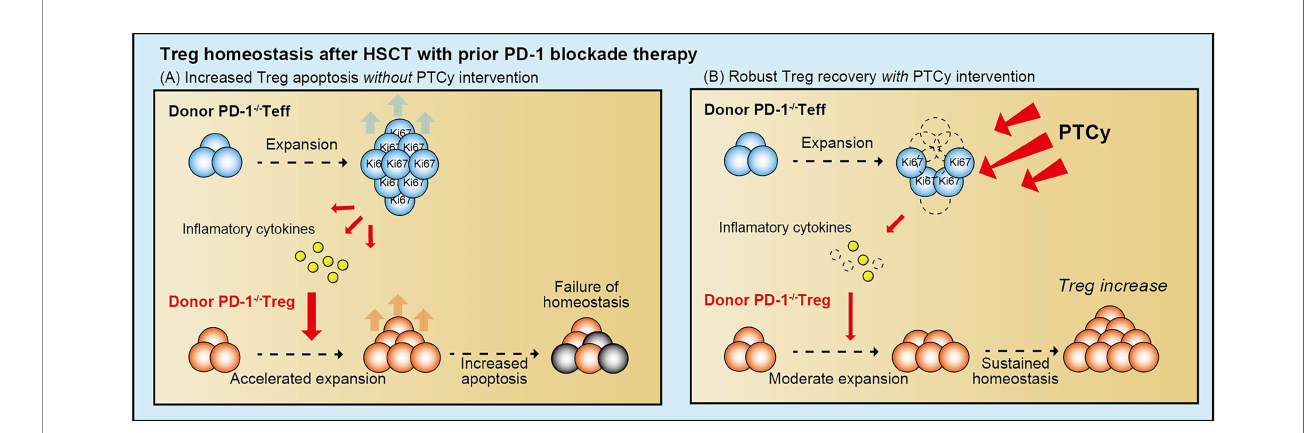
FIGURE 5 | The role of PD-1 in Treg homeostasis after allogeneic HSCT. PD-1 de fi cient effector T cells aggressively proliferate after HSCT and produce large amounts of in fl ammatory cytokines. The highly in fl ammatory cytokine milieu accelerates the proliferation of PD-1 de fi cient Tregs, but they cannot maintain proliferation due to their high susceptibility to apoptosis. Unbalanced reconstitution of T-cell subsets results in severe GVHD (A) . In contrast, with PTCy intervention, alloreactive proliferative effector T cells are ef fi ciently eliminated, contributing to reduced in fl ammatory cytokine production. It enables Tregs to restore the appropriate levels of proliferation and maintain homeostasis, which contributes to the prevention of severe GVHD (B) . PD-1, programmed cell death 1; Treg, regulatory T cell; Teff, effector T cell; PTCy, post-transplant